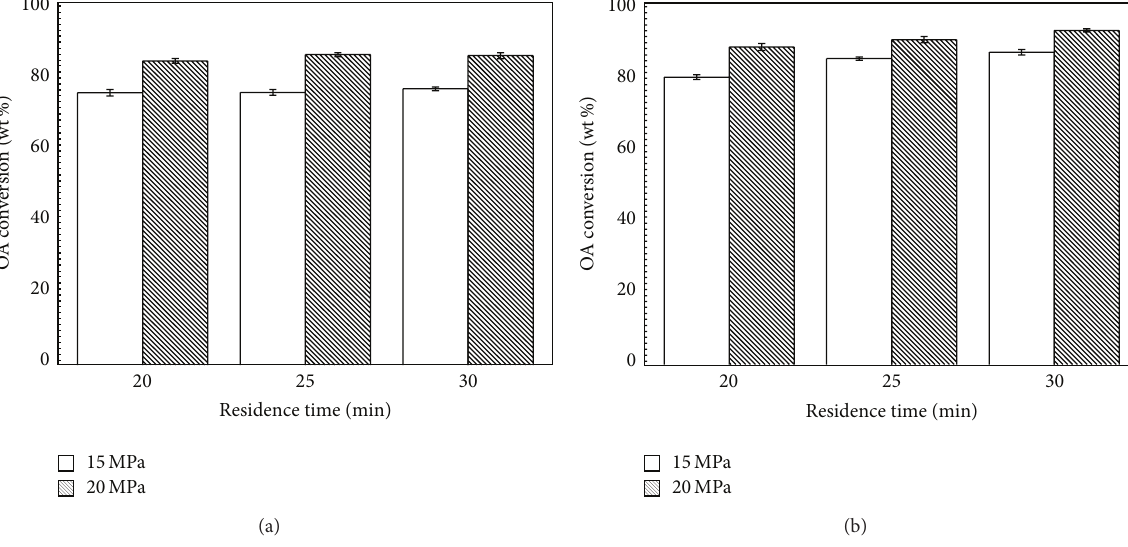
Figure 2: Effect of pressure on the conversion of oleic acid in molar ratio 1: 6 and temperature: 523 K (a) and 548 K